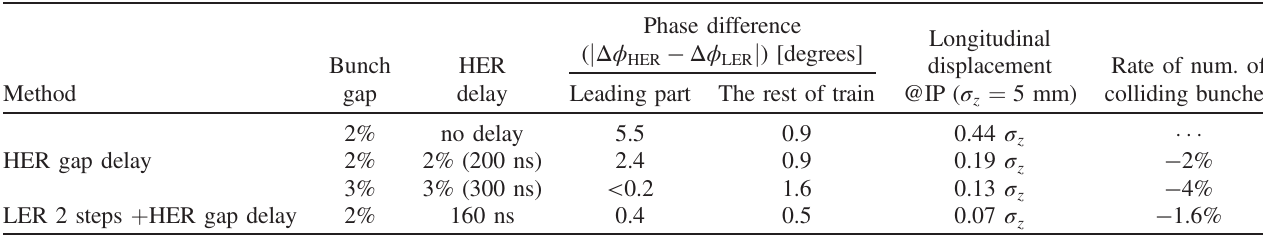
and the bunch s . The gap lengths are g and g for L H s g